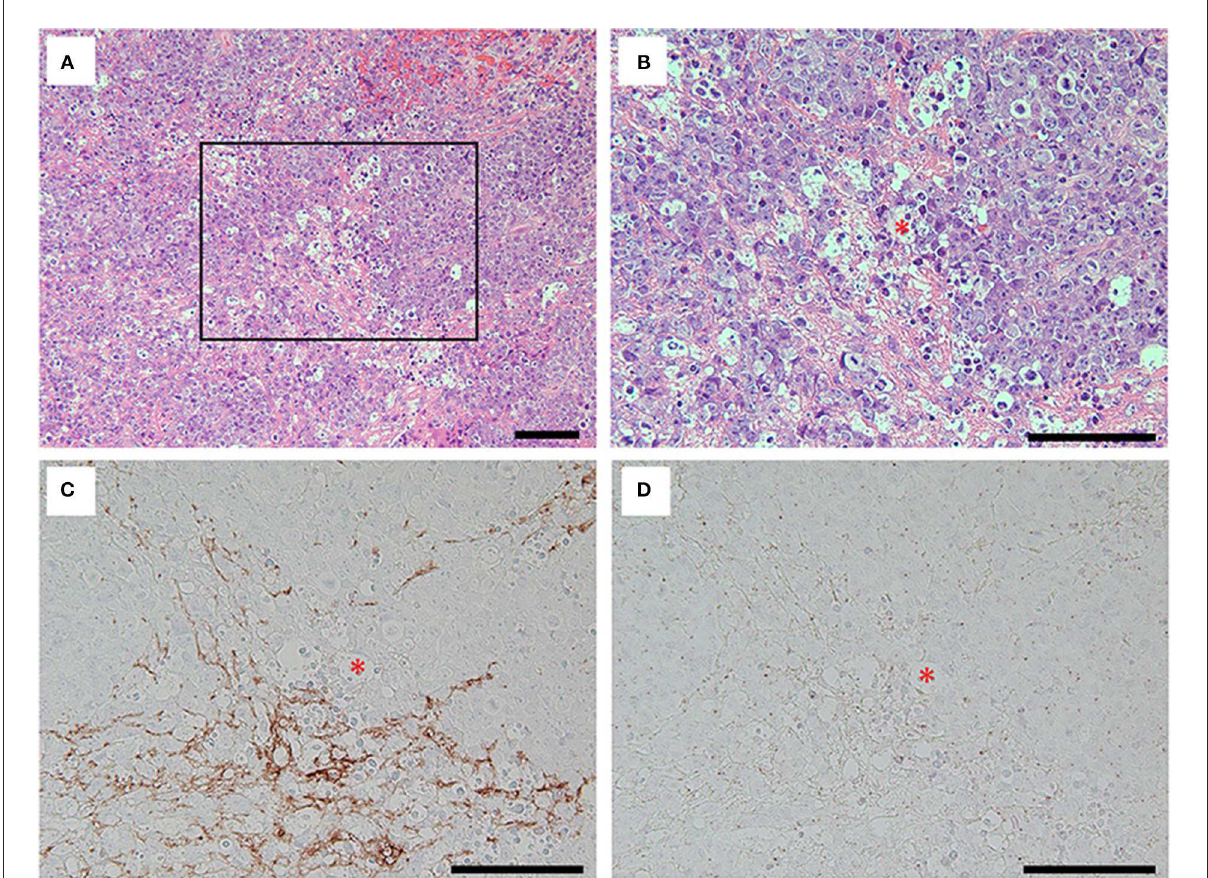
FIGURE3 Hematoxylin and eosin (H&E) staining (A, B) and immunolabeling with the antibodies against grail fibrillary acidic protein (GFAP) (clone G-A-5; Sigma, MO, US) (C) and NR1 (D) for the tumor cells. Note that H&E staining of the removed brain specimens showed foci of highly proliferative atypical cells interposed with basophilic matrix (A) . The tumor cells with irregular nuclei and frequent mitoses [ (B) , inset in (A) ] were not immunolabeled with commercial antibodies against GFAP (C) nor NR1 subunit of NMDAR (D) , while the basophilic matrix on H&E staining was immunolabeled with commercial antibody against GFAP (C) . Asterisks in red (B–D) indicate the same blood vessel, and all bars = 100 µ